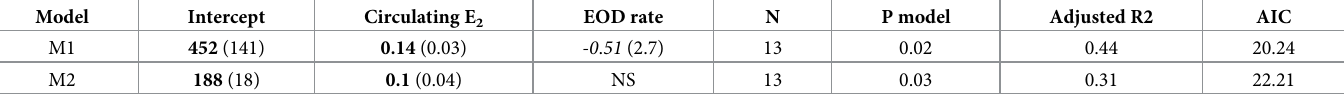
Table 2. GLM models that presented the best adjustment to explain DNN in females during the breeding season with data obtained in Survey 2. Model intercept and explanatory variables are expressed as Mean (SD). For each parameter, the value is shown in bold if statistically significant (p < 0.05), in italic if marginal (p < 0.1), and expressed as NS if non-significant. Model 1 and Model 2 did not present significant differences by the Akaike information criterion (AIC).